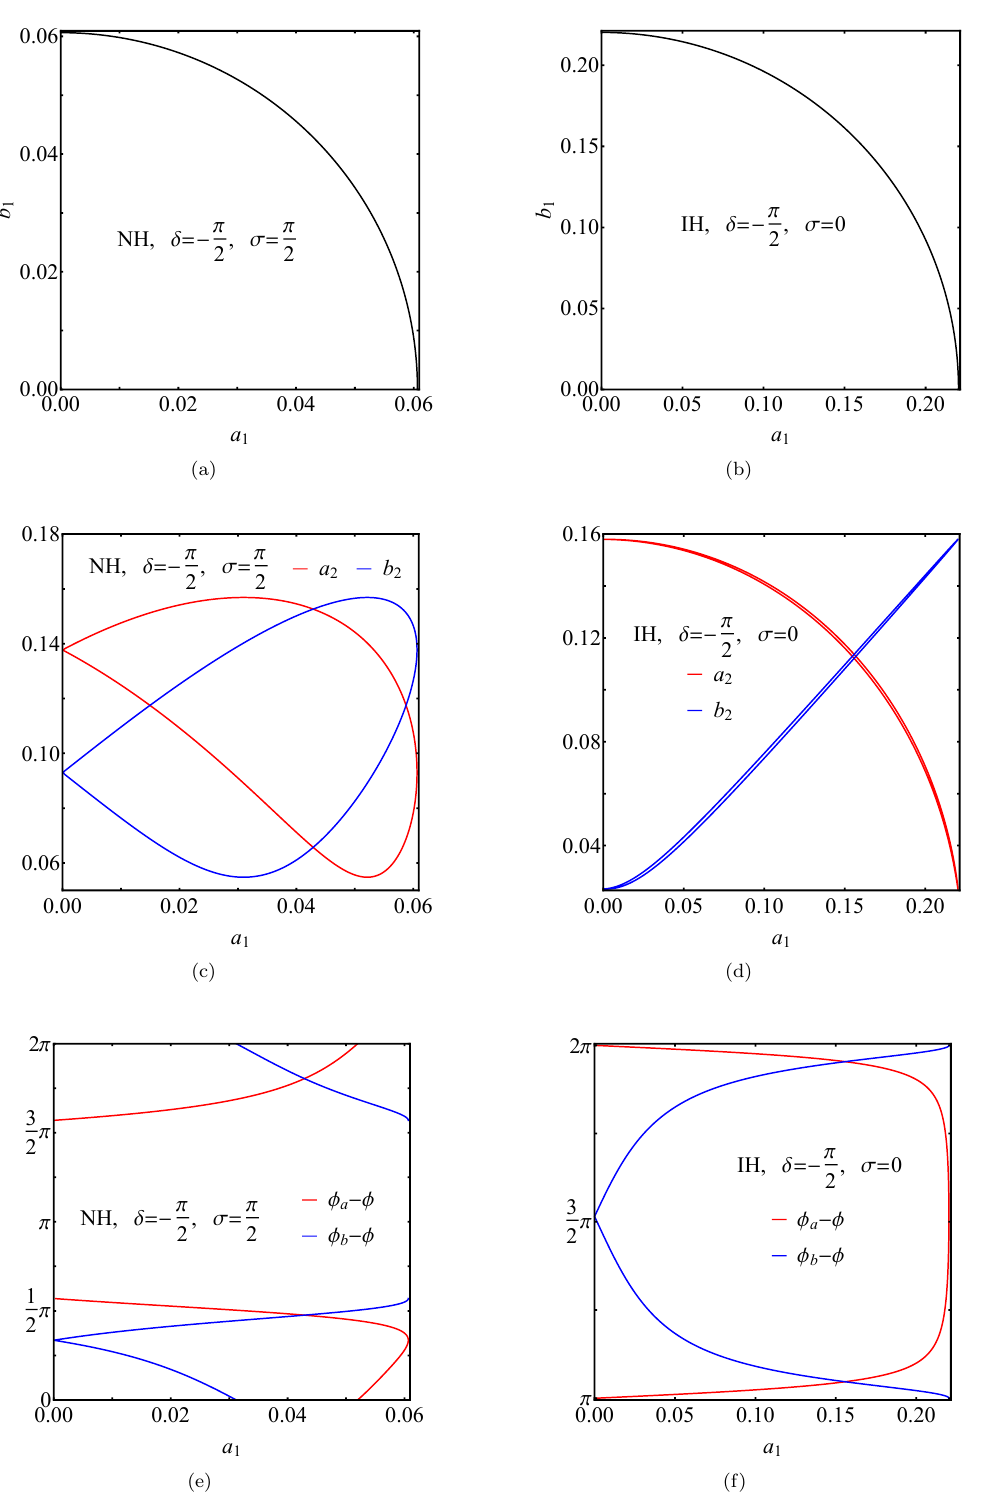
Figure 1 . The allowed values of a NH (or IH) case and (cid:14) = (cid:0) (cid:25)=